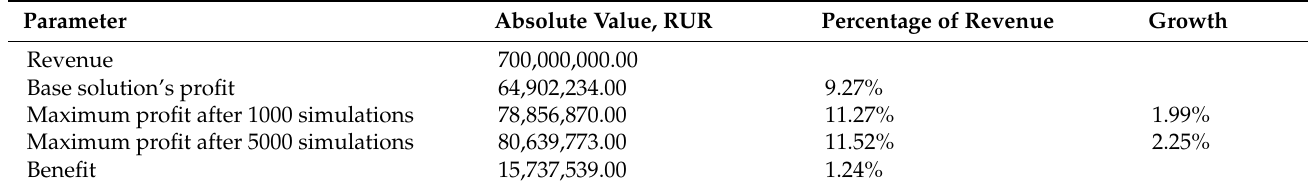
Table 3. Financial indicators of the demo case depending on the number of simulations